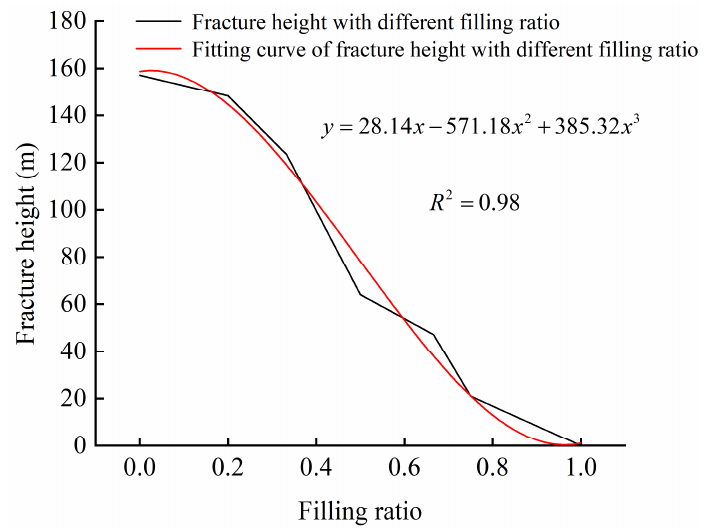
Figure 11. The fit curve of the development height of overlying strata fractures under different fill- ing ratio